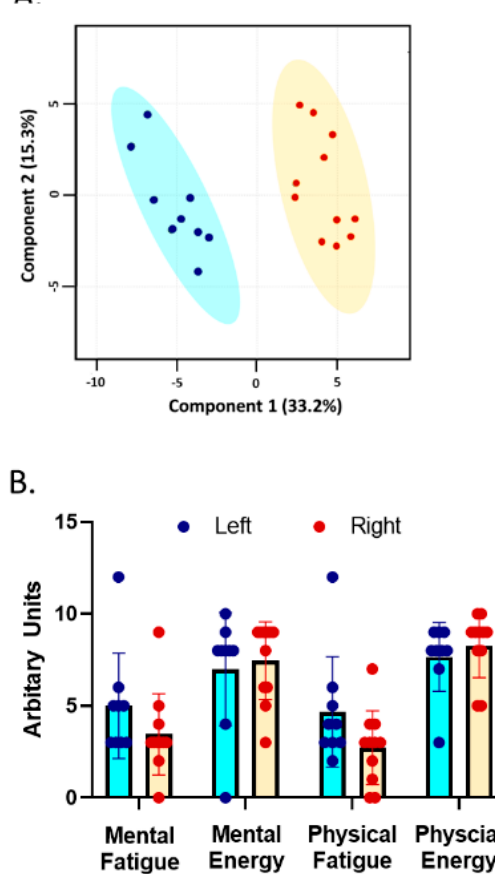
Figure 1. A principal component analysis (PCA) for the 20 survey subjects. ( A ) clearly shows two distinct clusters: left blue and right red. ( B ) shows the average ± SD for each trait. MF, ME, PF, and PE were not significantly different between the two clusters.